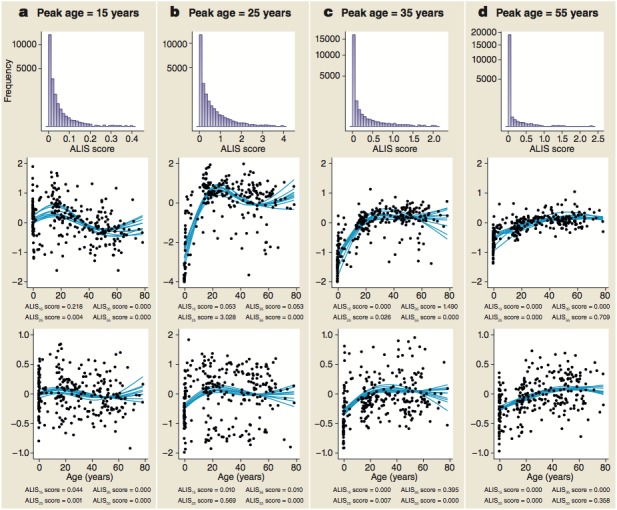
Distribution of ALiGeT scores at 15 (a), 25 (b), 35 (c) and 55 years (d) along with examples of trajectories, their scores and expression data.The top row of panels shows the frequency distribution of ALiGeT scores. The second row of panels shows the ten interpolated trajectories with highest scores that upregulate prior to turning. Beneath each graph is a list of the four mean scores for these trajectories at the four representative ages. The third row of panels shows ten trajectories with low scores (below the median). Beneath each graph is a list of the four mean scores for these trajectories at the four representative ages. The data points shown in the second and third rows of panels are the individual data points used to generate one of the trajectories shown as a line.